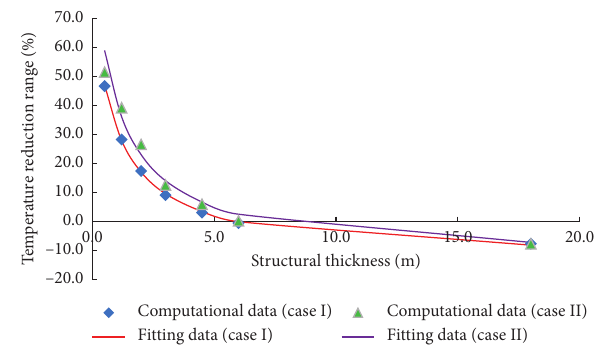
Figure 25: Comparison between ANSYS calculation data and fitting